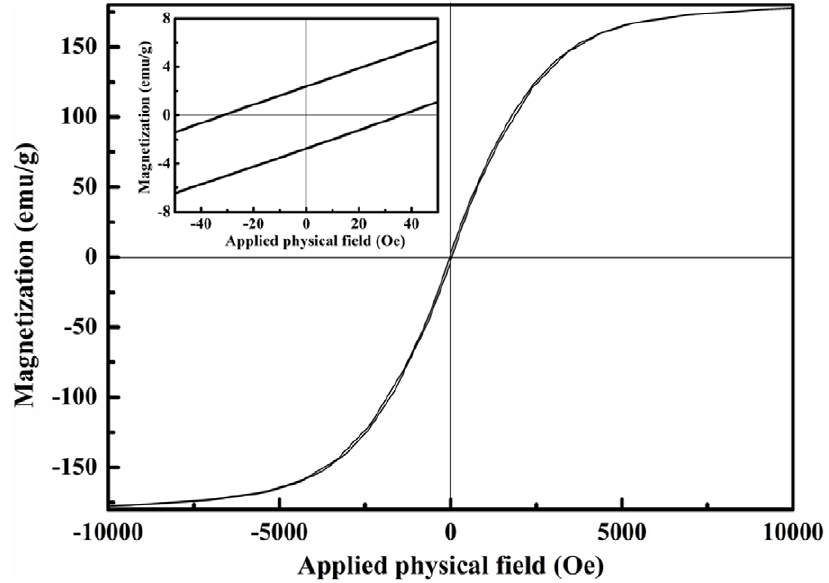
Figure 3. Magnetic hysteresis loop at room temperature for chain-like Co flower.